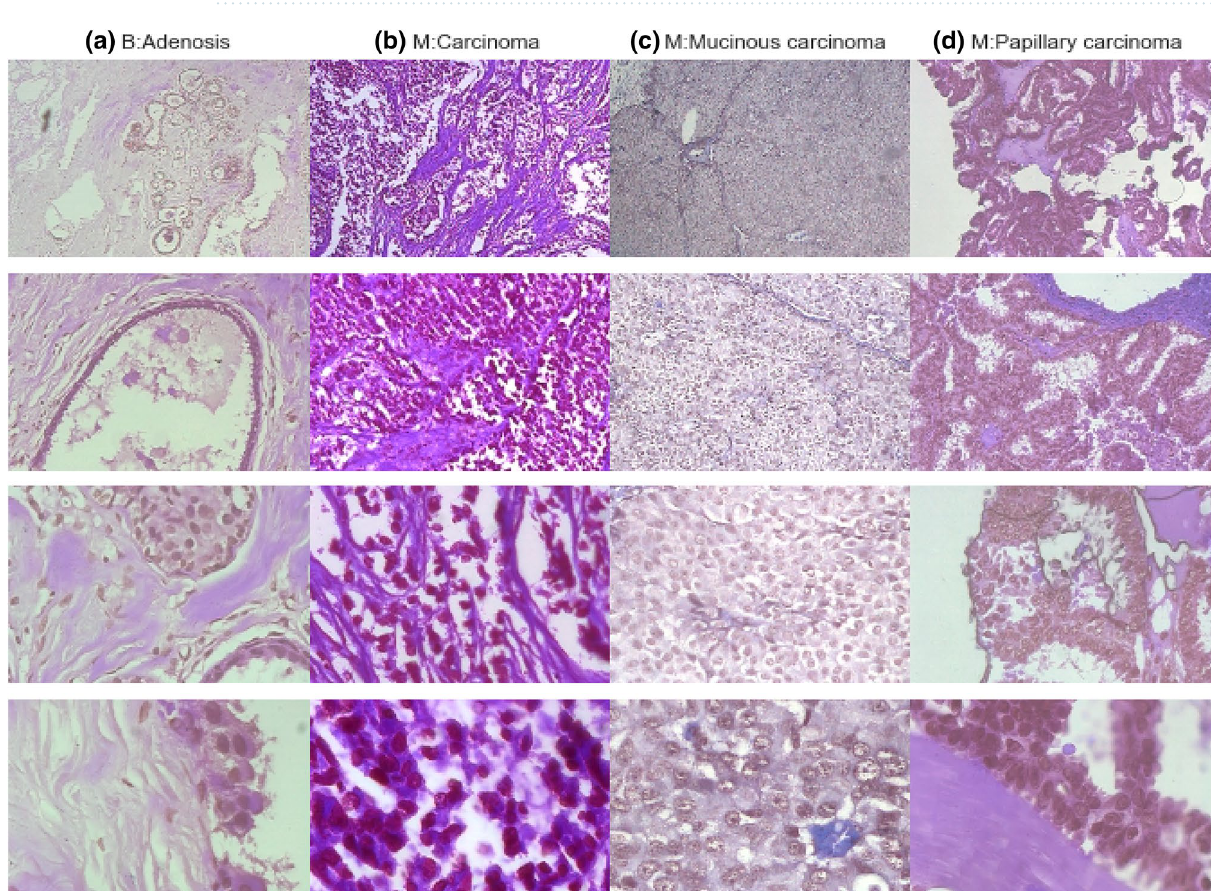
Figure 3. Sample images from the BACH datasets showing ( a ) normal ( b ) benign ( c ) in situ carcinoma and ( d ) invasive carcinoma cases.